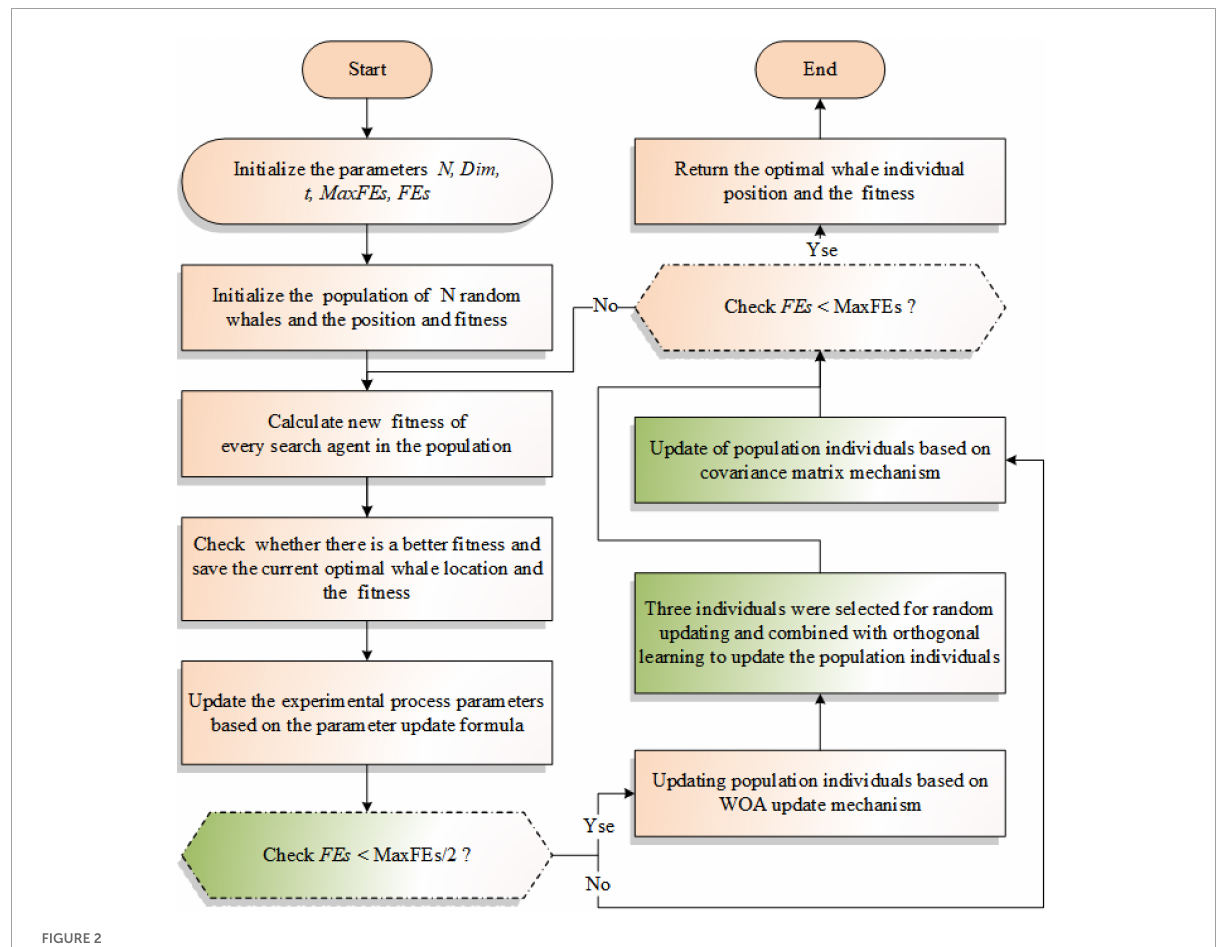
FIGURE2 Flowchart of the